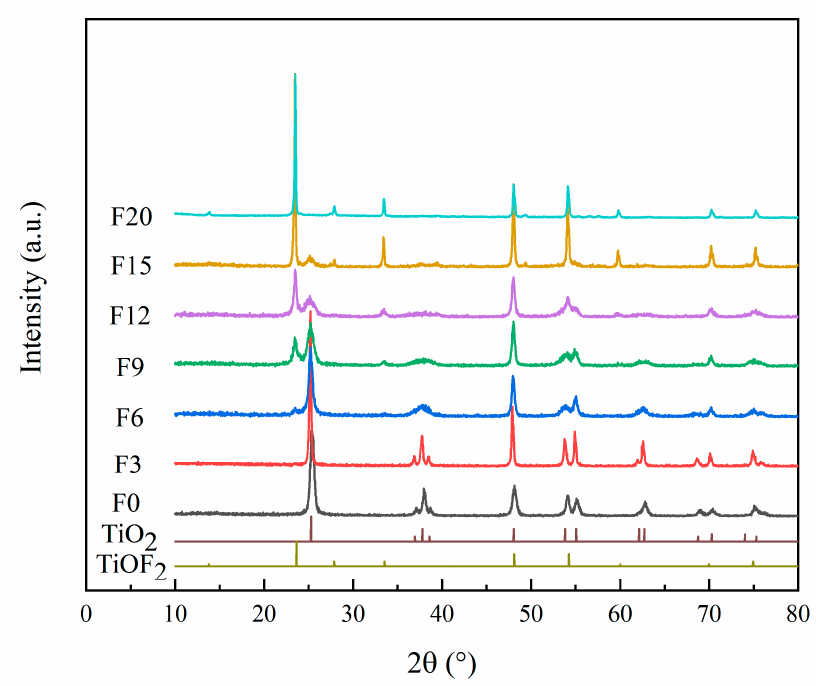
Figure 1. XRD patterns of samples.